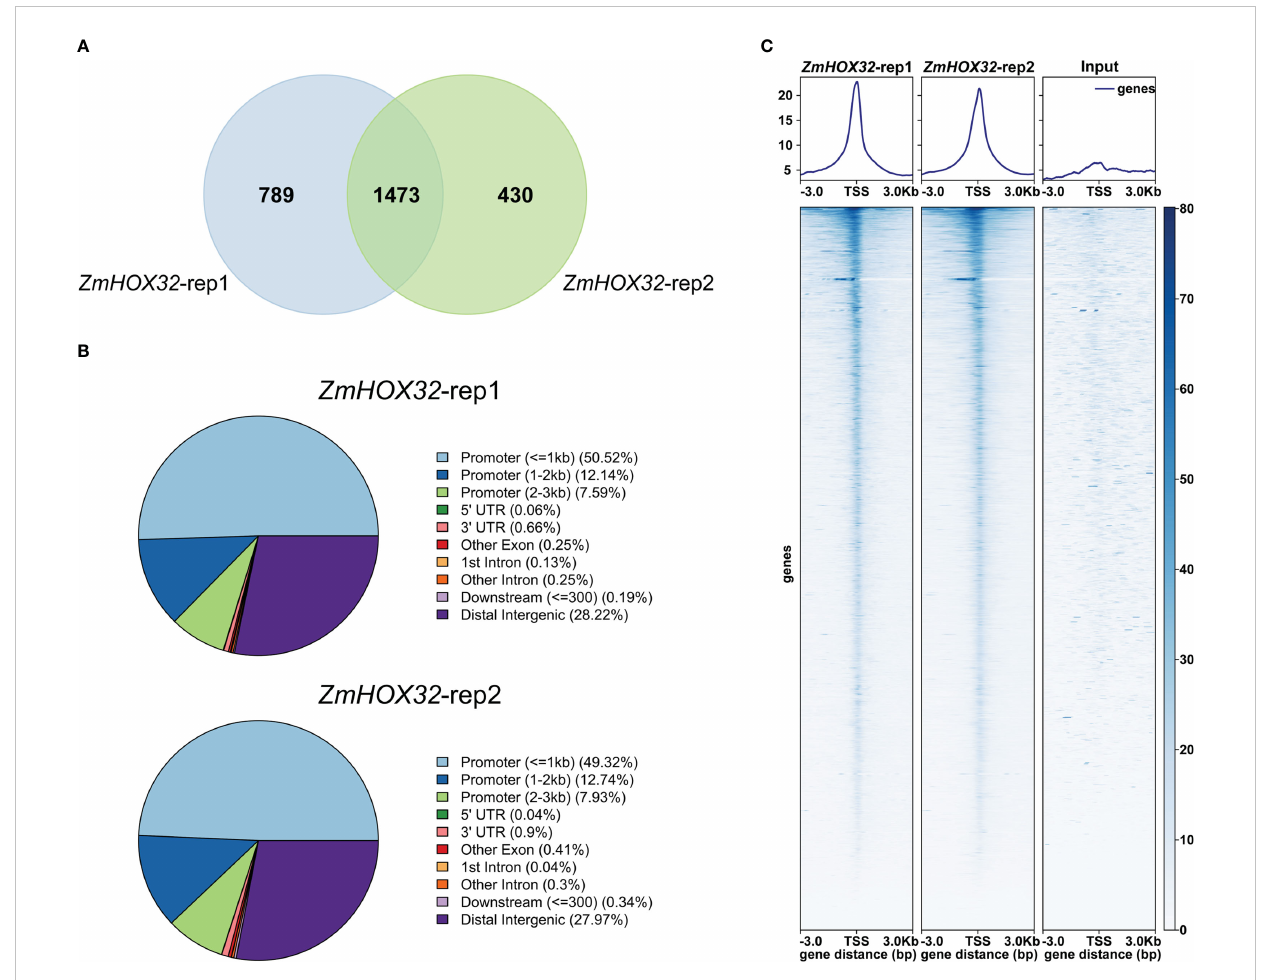
FIGURE 5 tsCUT&Tag reveals the genome-wide binding position of ZmHOX32 . (A) The overlap between the downstream target genes of the two replicates of ZmHOX32 . (B) Genome-wide binding site map of ZmHOX32 two repeats. (C) Distribution of ZmHOX32 tsCUT&Tag peaks at 3 Kb upstream and downstream of the